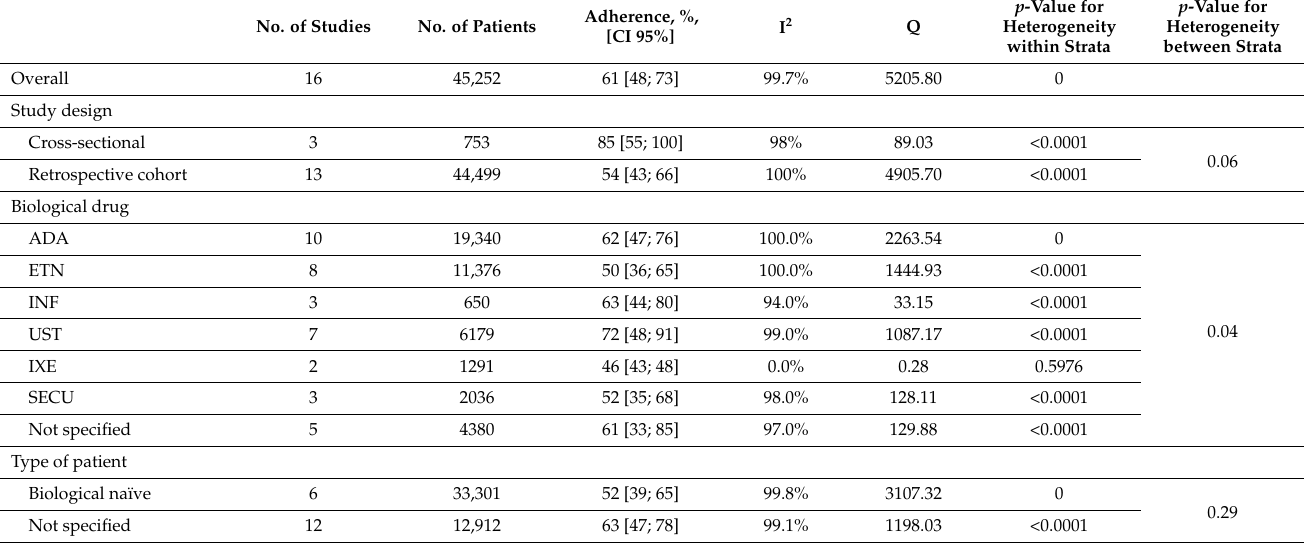
Table 2. Pooled proportions of adherent patients stratified according to study design, type of biological drug, and type of patient.